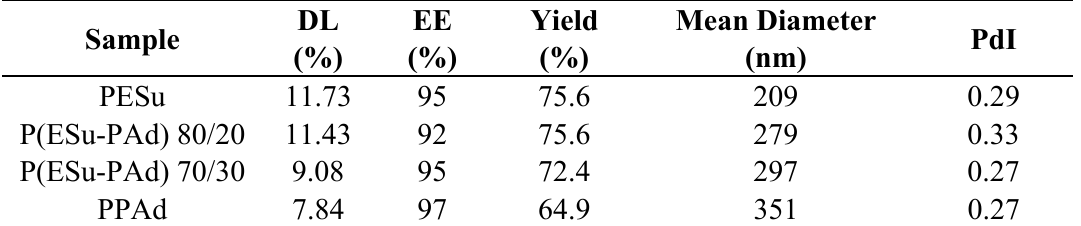
Table 2. Average values of nanoparticle yield, drug loading content, entrapment efficiency and particle size of Raloxifene HCl loaded nanoparticles.